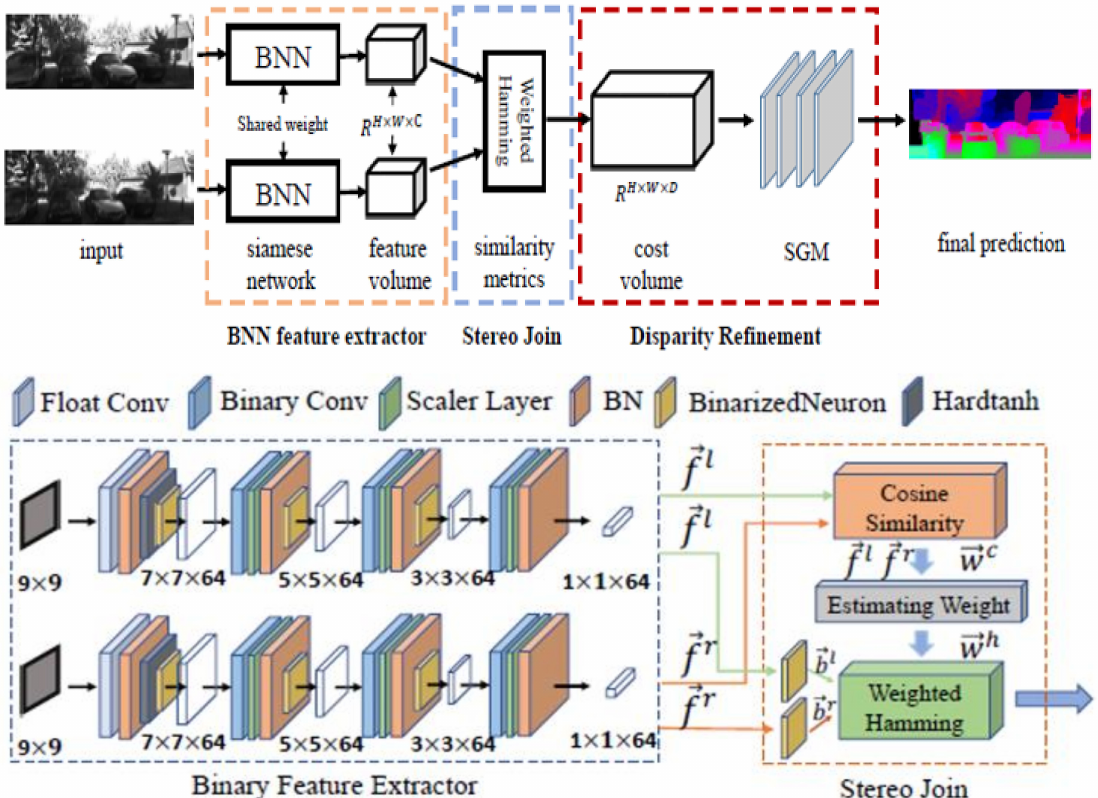
Figure 6. GPU-based approach for real-time stereo estimation [32]. (Reprinted with permission from ref. [32]. Copyright 2021